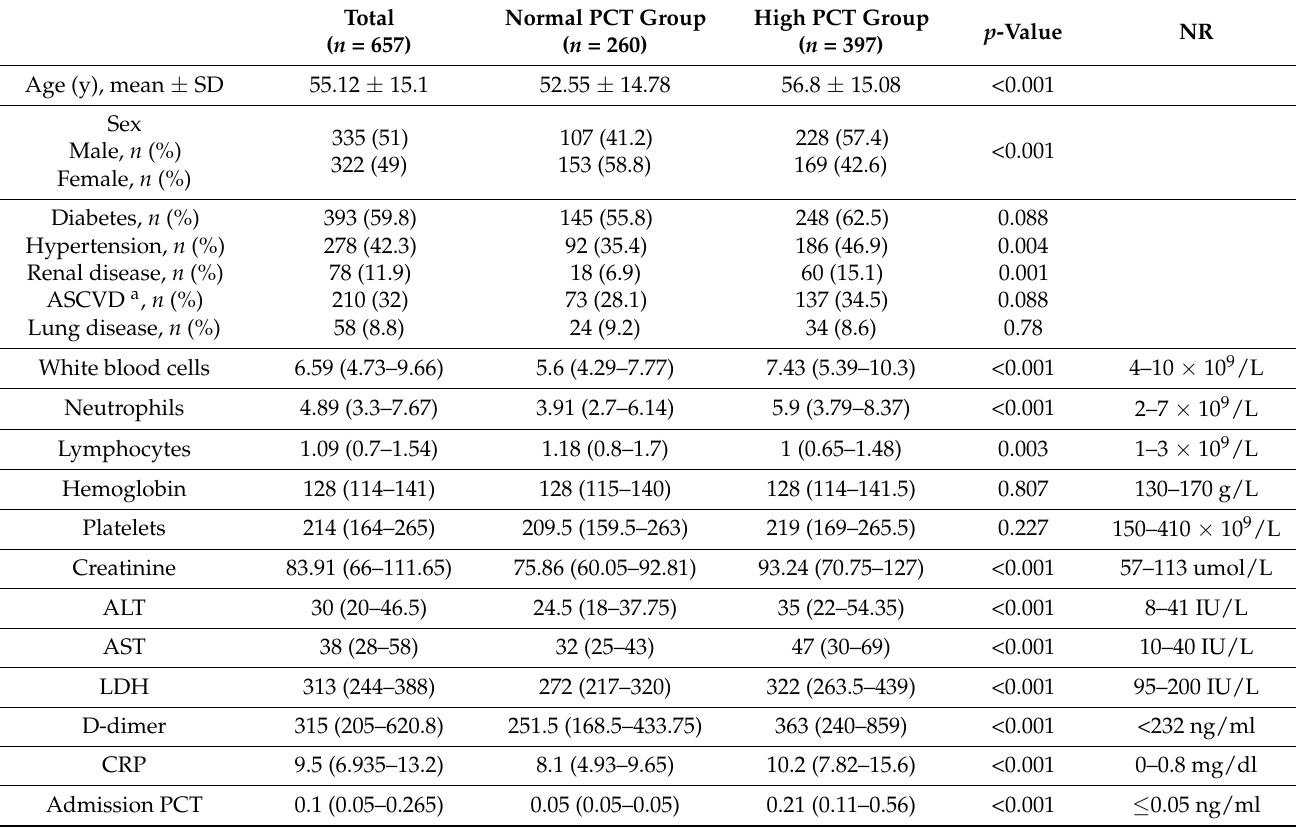
Table 1. Demographics, comorbidities, and laboratory parameters for the normal and the high PCT groups.